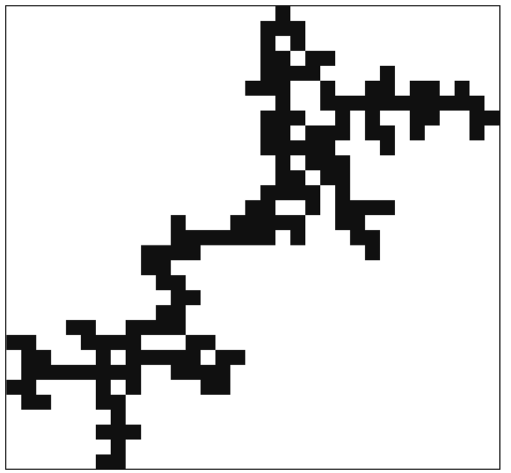
Figure 3. Typical two-dimensional ( d = 2 ) energy cluster of the site-diluted TIM with a bounding box at (cid:31) p = − 0.2 with L = 8, 192 . The cluster is connected and has a tree-like